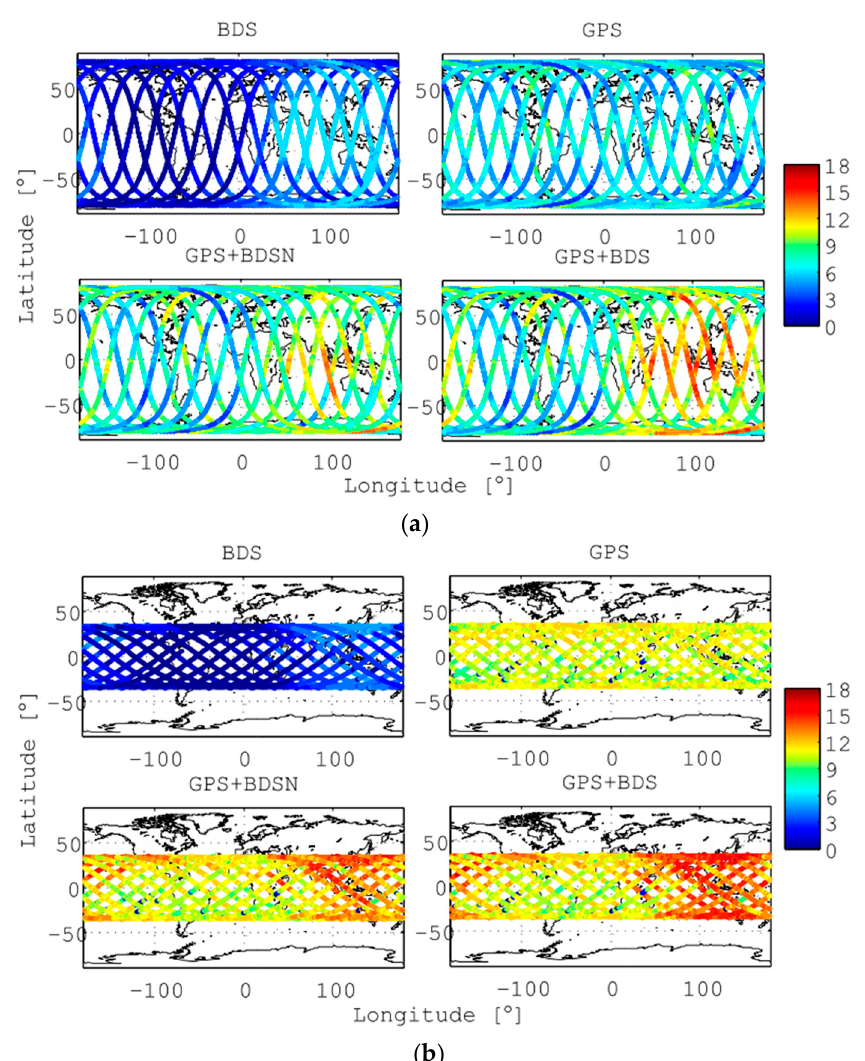
Figure 9. The number of tracked GNSS satellites for different types of GPS/BDS combinations: ( a ) for the FY3C satellite; ( b ) for the YG30/SAT1 satellite. Table 4. Comparison of position dilution of precisions (PDOPs) for different GPS/BDS combinations.